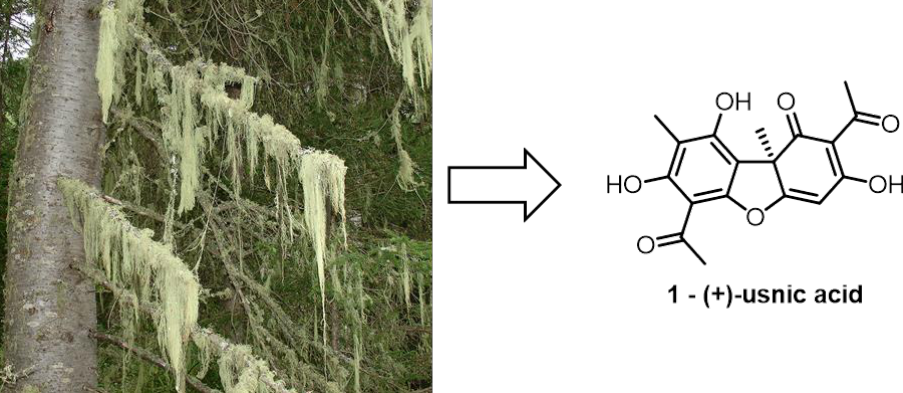
Figure 1. Left : Usnea longissima ; Right : structure of (+)-usnic acid 1 . Usnic acid is a secondary metabolite of the lichen species Usnea , Cladonia , Alectoria , and many others. It has a wide range of biological activities: antimicrobial, antitumor, anti-inflammatory, and antiviral [14]. Earlier it was shown that (+)-usnic acid shows activity against Epstein–Barr virus and rat polyomavirus [15]. In a series of studies it was